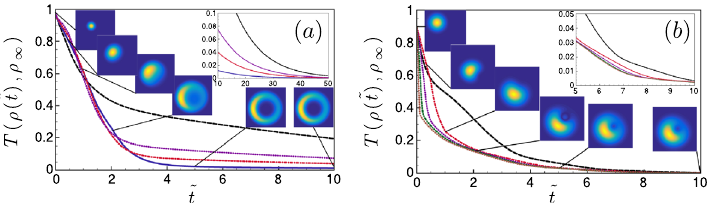
Figure 3. Performance of the shortcut to quantum synchronization: ( a , b ): Trace distance T (ρ( t ) , ρ ∞ ) of the density matrix ρ( t ) to the stationary solution ρ ∞ as a function of time for the weak ( a ) and strong ( b ) nonlinear regimes with the respective shortcuts of Fig.2a and Fig.2b with (cid:31) y = 0 . We have taken the durations ˜ τ = 2 (solid blue line, ( a )), ˜ τ = 1 (red dash-dotted line, ( a , b )), ˜ τ = 0.5 (dotted purple line, (a,b)) ˜ τ = 0.25 (green dash-double dotted line, ( b )) and ˜ τ = 0.125 (brown dotted line, ( b )). The black-dashed line stands for a constant drive of amplitude ˜ ε 1 = 1 and ˜ ε 2 = 0 . The insets represent the Wigner distribution | W ( x , y , τ) | ( x = Re [ α ] and y = Im [ α ] ) for ( a ) the shortcut designed with ˜ τ = 2 in the weakly nonlinear regime and for ( b ) the shortcut designed with ˜ τ = 0.5 in the strongly nonlinear regime for the considered times ˜ t = 0, 0.5, 1, 2, 5, 10